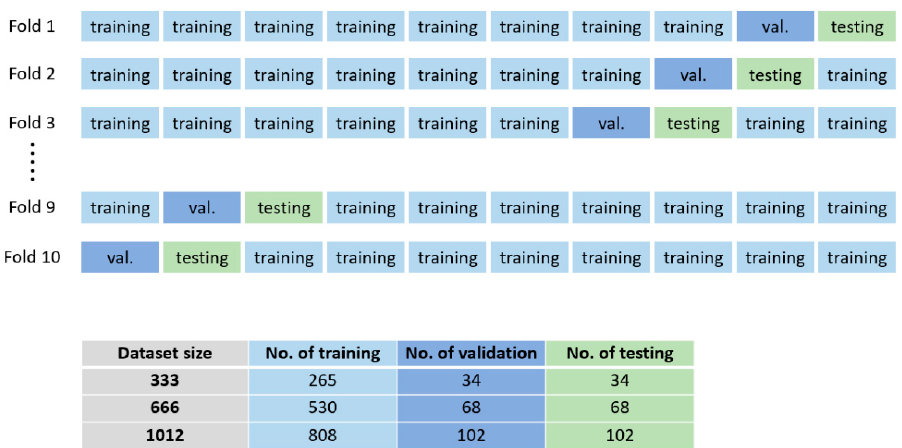
Figure 6. Ten-fold cross-validation. For each dataset, the training, validation, and testing ratios are 8:1:1 (numbers in table). Ten-fold cross-validation was applied to different dataset sizes.